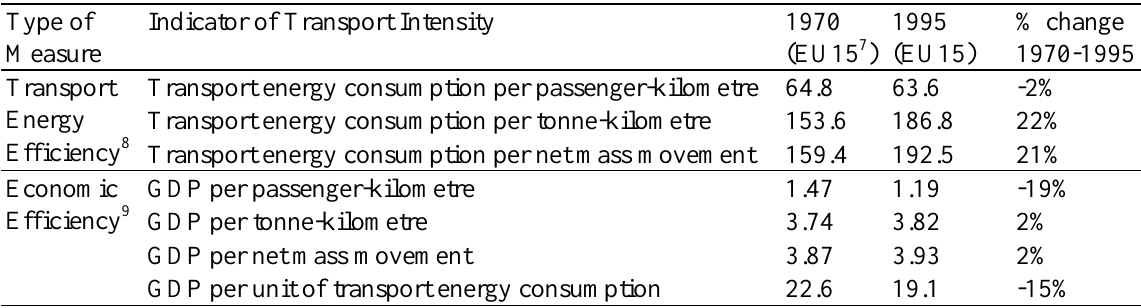
Table 2. Indicators of Transport Intensity in Europe,